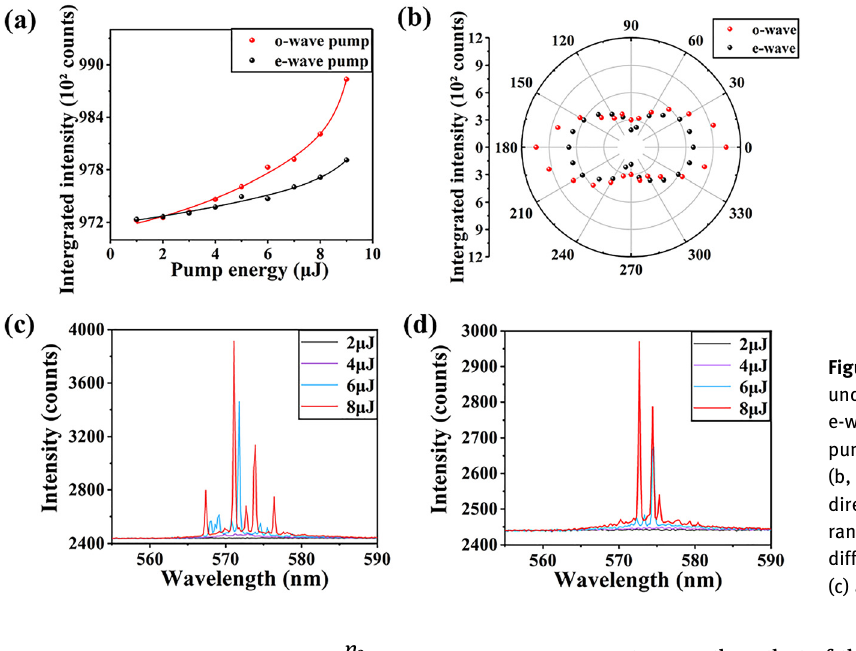
Figure 2: The integrated intensity of the RLs under o-wave pumping (red dot) and e-wavepumping(blackdot)asafunctionof pump energy (a) and polarization direction (b, θ is the angle between polarization direction and the horizontal plane), and random lasers (RLs) emission spectra at different pump energy for o-wave pumping (c) and e-wave pumping